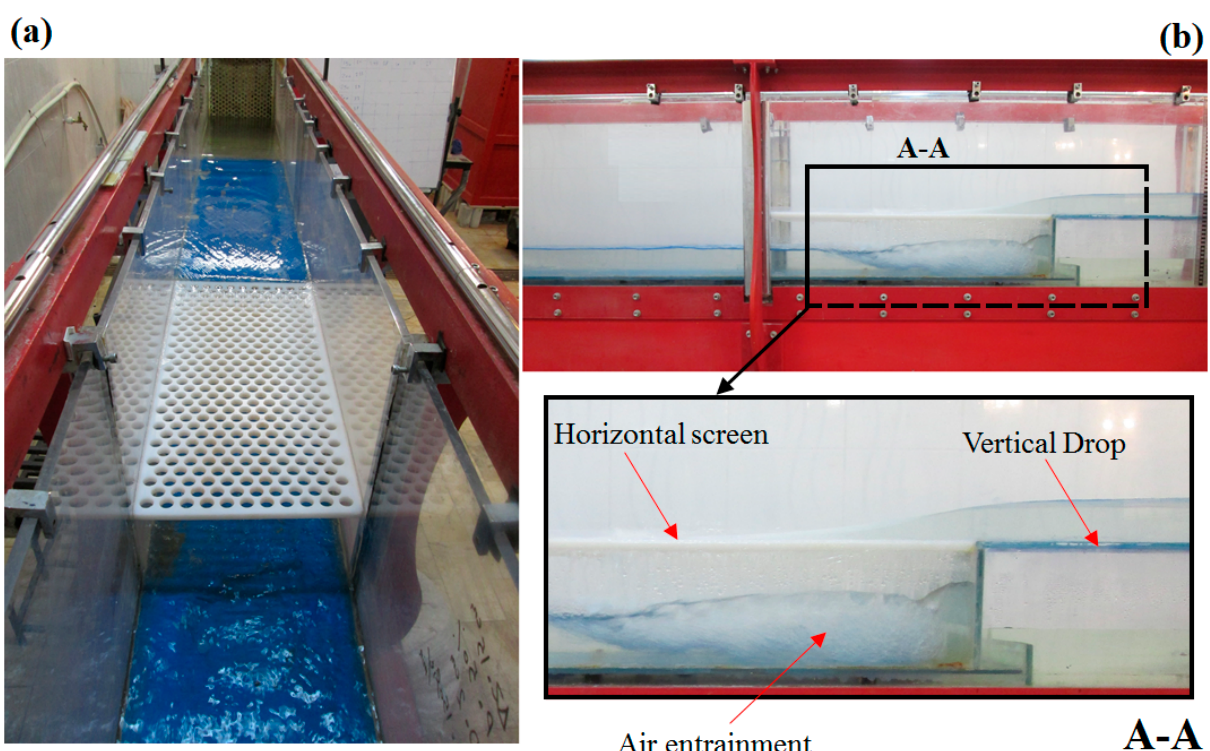
Figure 2. Experimental facility of the present study. ( a ) Top view; ( b ) side view.